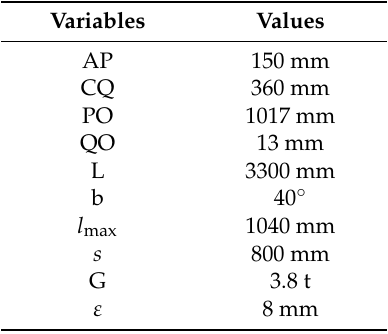
Table 1. Parameters of the FW50GL steering